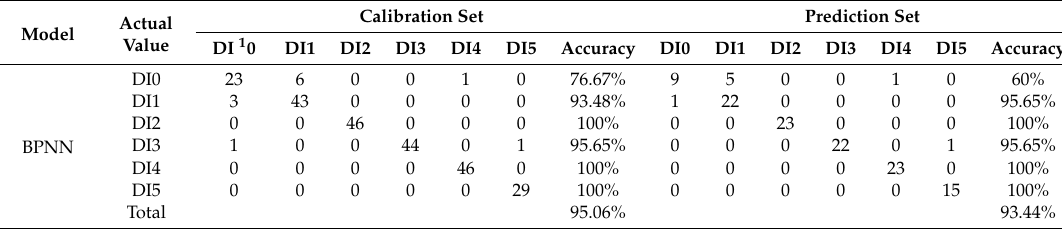
Table 1. Detection accuracy of six infestation degrees by the BPNN model based on full spectra.